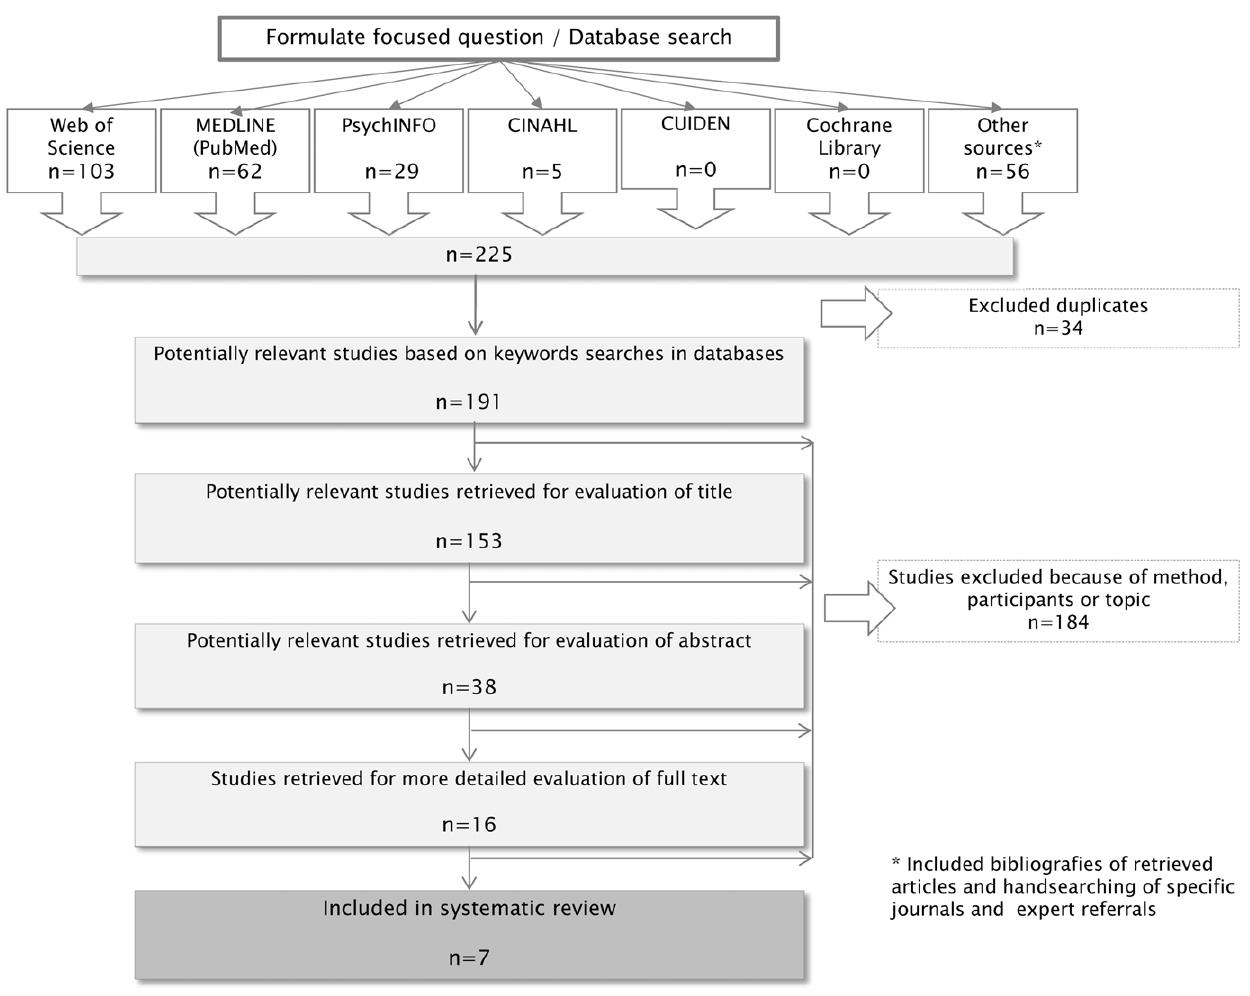
Figure 2. Flowchart of search results.